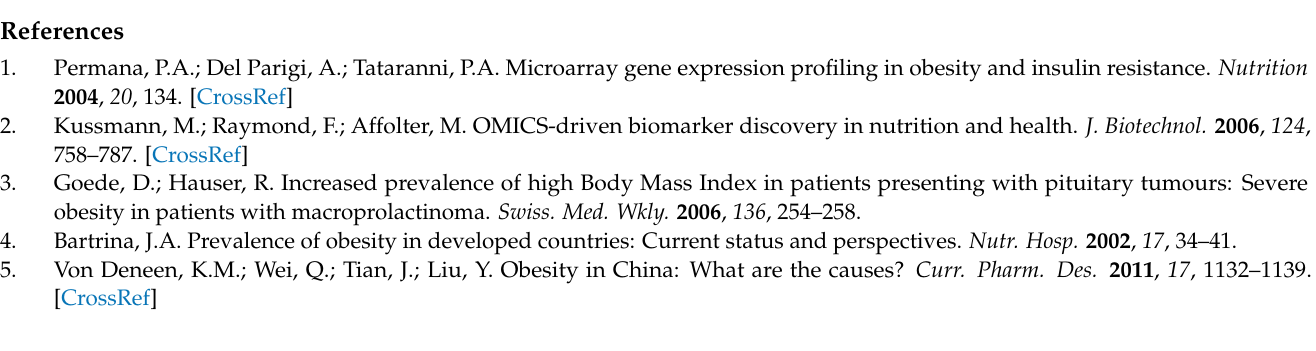
Table S2: The tertiary function of predicted gene, Table S3: Metabolic pathways affected by a high fat diet on serum, Table S4: Metabolic pathways affected by a high fat diet on fecal, Table S5: Diet ingredients of the control group, Table S6: Diet ingredients of the high fat diet